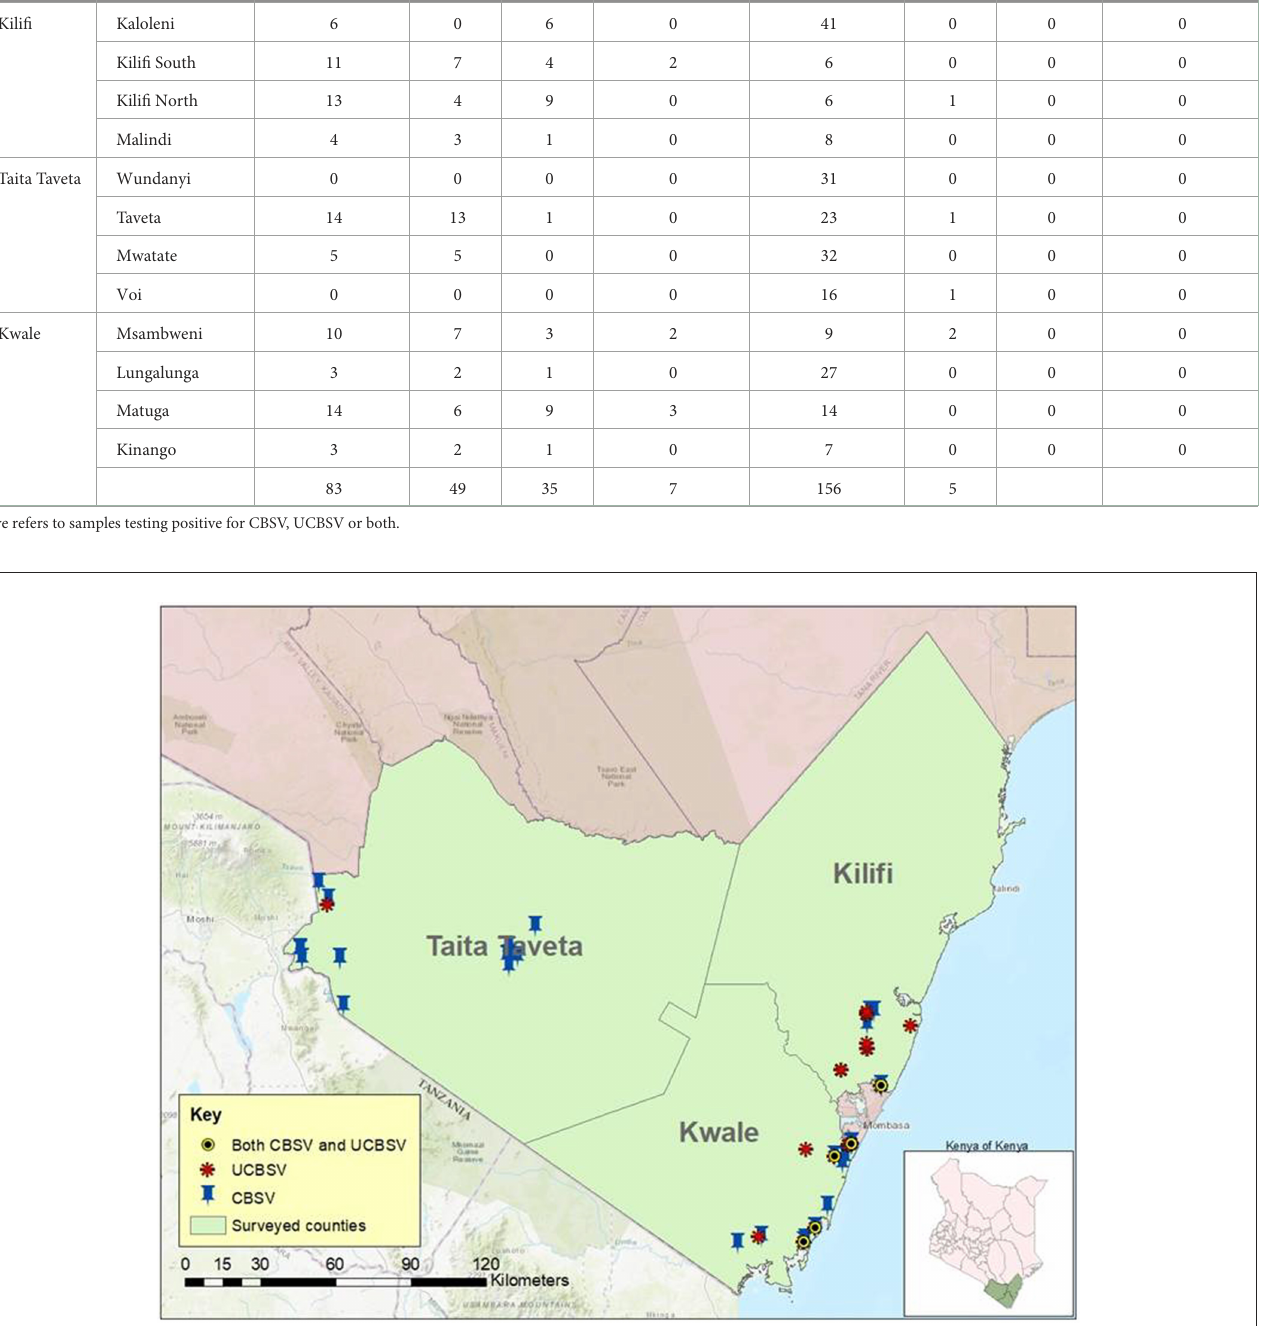
2005; Legg et al., 2014). Munguti et al. (2021) reported increased diversity of whitefly species from cassava farms at the coastal region of Kenya including the Bemisia tabaci haplotypes. Future studies need to investigate the possible link of the increasingly